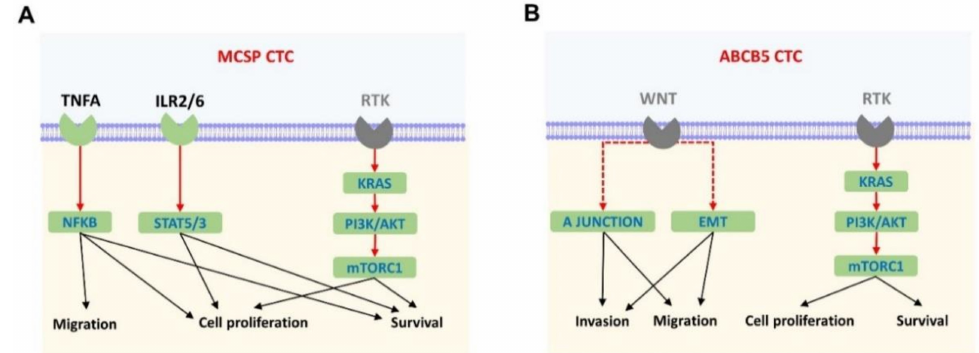
Figure 3. MCSP- and ABCB5-enriched CTCs exhibit distinct transcriptional programming, with ABCB5 CTCs displaying an invasive phenotype. Schematic representation of cellular hallmarks enriched by the genes found to be differentially up-regulated in ( A ) MCSP- and ( B ) ABCB5-enriched CTCs. Enriched cellular hallmarks in CTCs are shown in green boxes, while genes shown in grey are those that were not found enriched in this study but are known to be important for melanomagenesis. Canonical pathway signalling is indicated by continuous arrows and dotted arrows indicates a previously reported interaction.